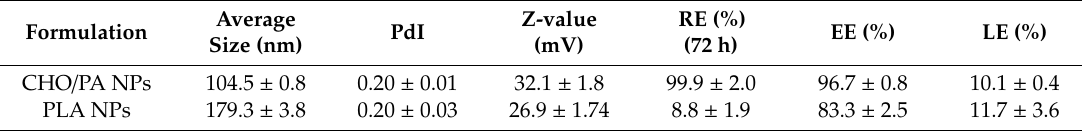
Table 3. Full characterization of DAS-loaded CHO / PA NPs and DAS-loaded Polylactide NPs (PLA